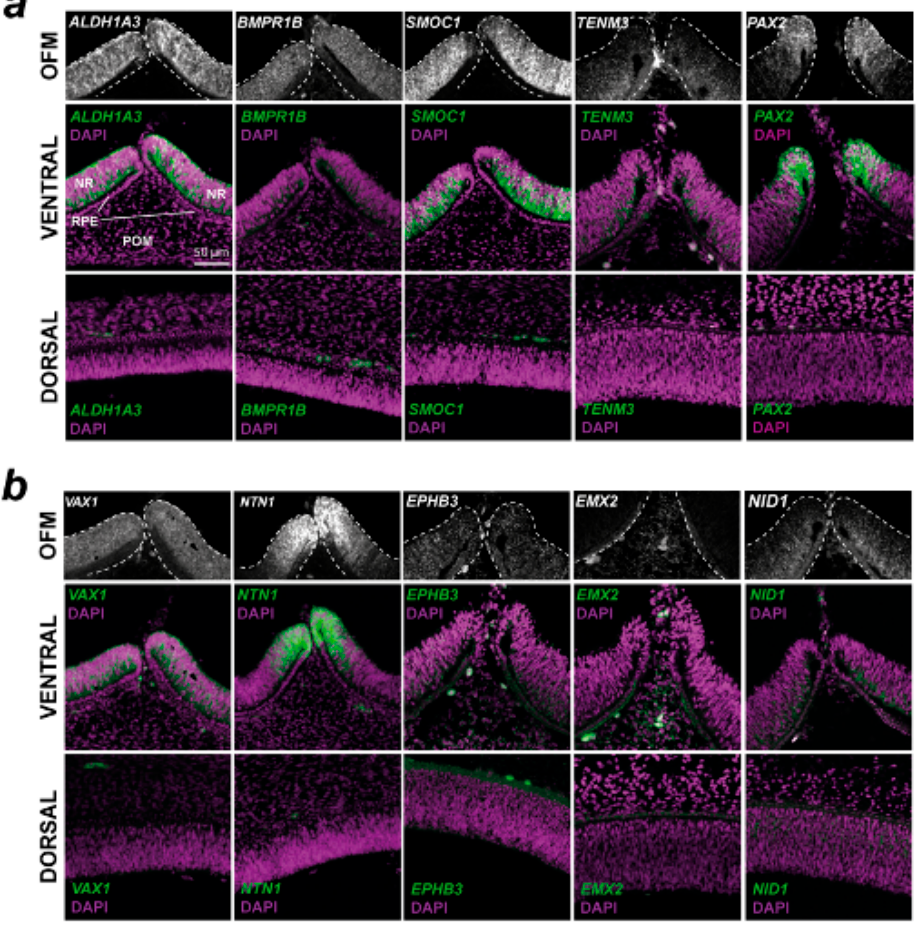
Figure 3. Spatial gene expression analysis for 10 conserved fissure-enriched genes in the developing chick eye. Fluorescent in situ hybridisation for ( a ) known coloboma gene targets and ( b ) OFC candidate genes identified in this study was counterstained with DAPI nuclear stain on chick eyes at HH28, immediately prior to fusion. Note that for EMX2, the OFM region highlights the POM region; expression was not observed in the NR or RPE. In both ( a , b ), Top: grayscale RNAscope probe signal without DAPI highlighting the mRNA signal in the immediate optic fissure margin region. Middle: mRNA probe and DAPI merged images of the broad ventral eye region. Bottom: Dorsal eye region with probe and DAPI merged. OFM, optic fissure margin; NR, neural retina; POM, periocular mesenchyme; RPE, retinal pigmented epithelium. Scale = 50 µ